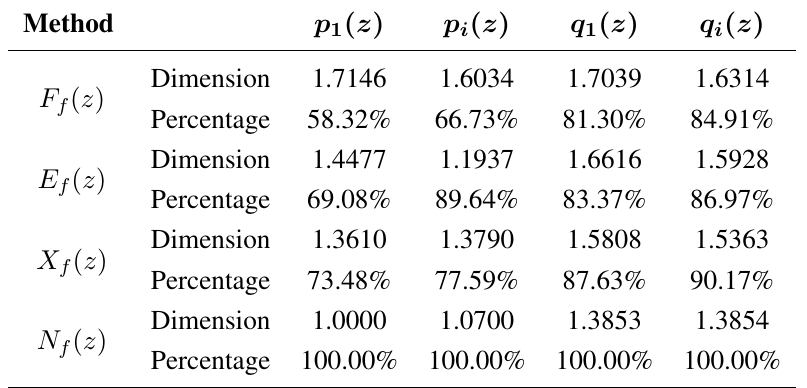
Table 1. Fractal dimension and percentage of Newton’s method vs. M4, M8 and